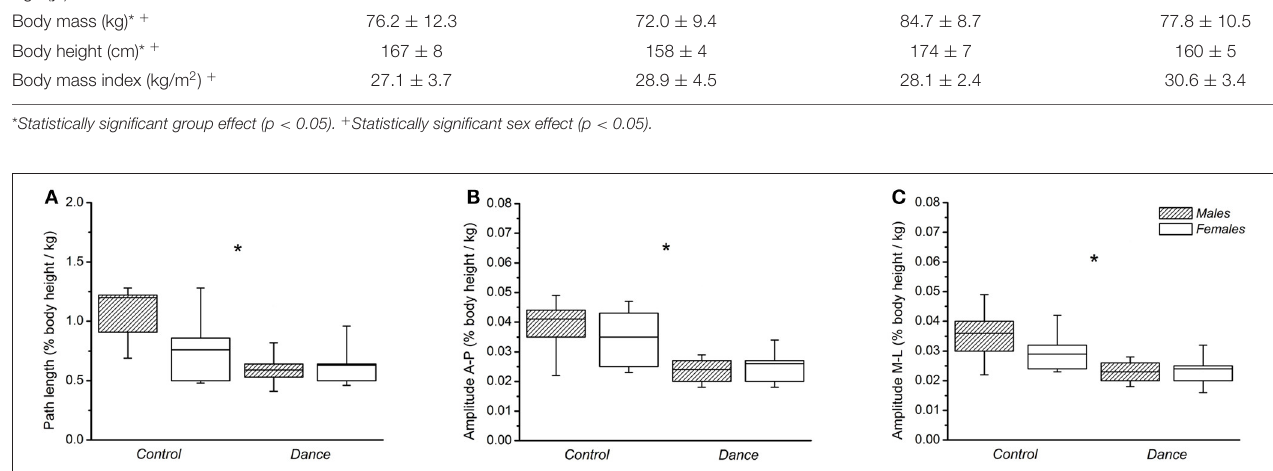
FIGURE 1 | (A) Normalized path length, (B) center of pressure (CoP)-amplitude in the anteroposterior direction, and (C) CoP-amplitude in the mediolateral direction in the one-legged quiet stance trials for men and women in the non-dancer (control) and dancer (dance) groups. *Statistically significant group effect ( p < 0.05).